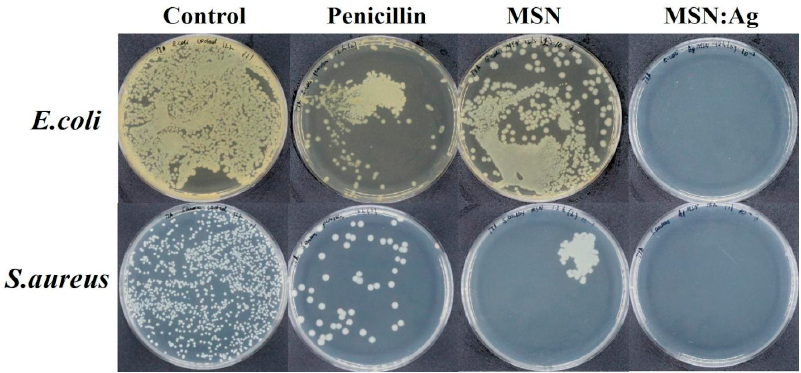
Figure 4. Bacterial viability assay using control, penicillin, MSNs, and MSN/Ag at 1 mg/mL after 12 h incubation with 1 × 10 8 CFU of E. coli and S. aureus